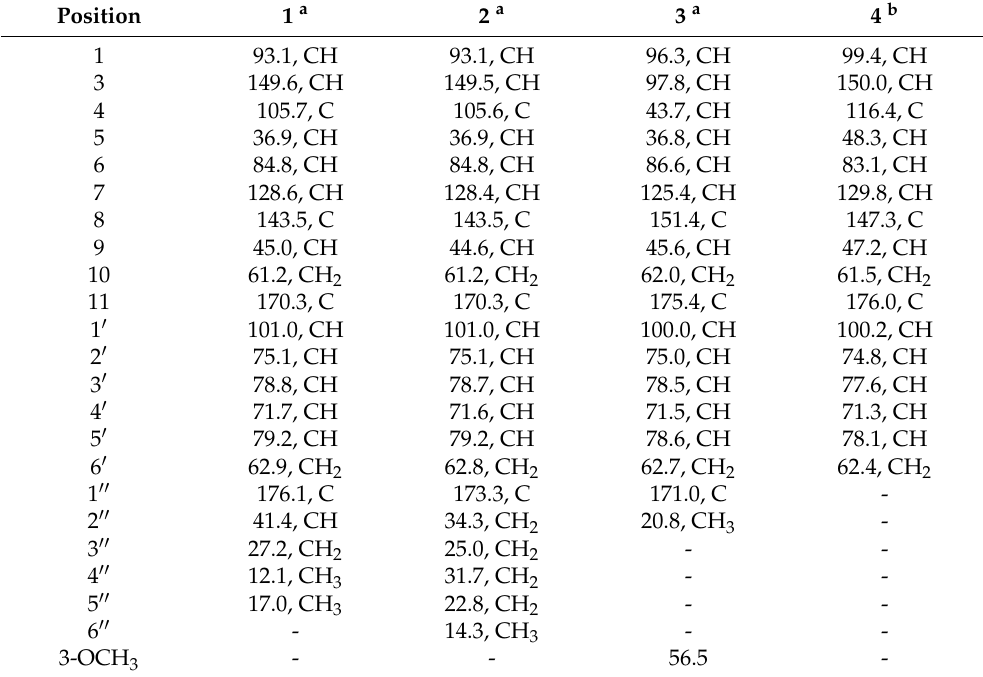
Table 1. 13 C-NMR spectroscopic data ( δ C , multiplicity) for compounds 1 – 4 (Supplementary Materials).